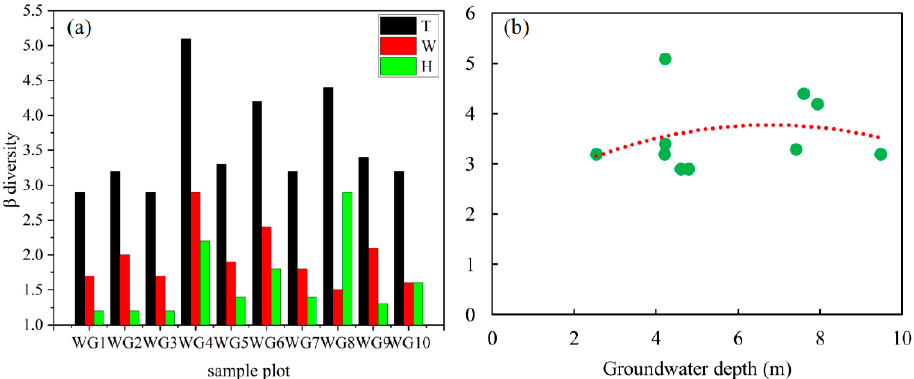
Figure 5. Spatial distribution of species replacement rate ( a ) and its relationship with groundwater ( b ). “H” refers to herbaceous plants, “W” refers to woody plants, and “T” (Total) refers to both herbaceous and woody plants.